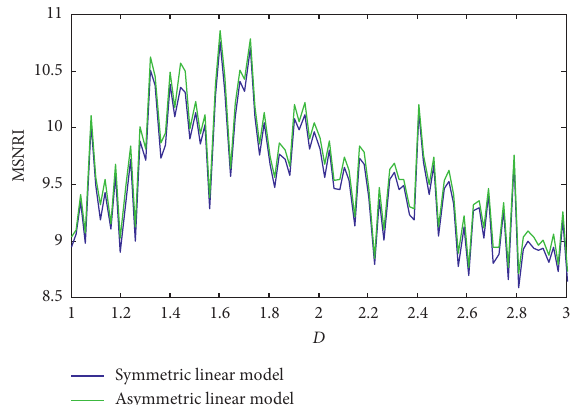
Figure 5: Average SNR